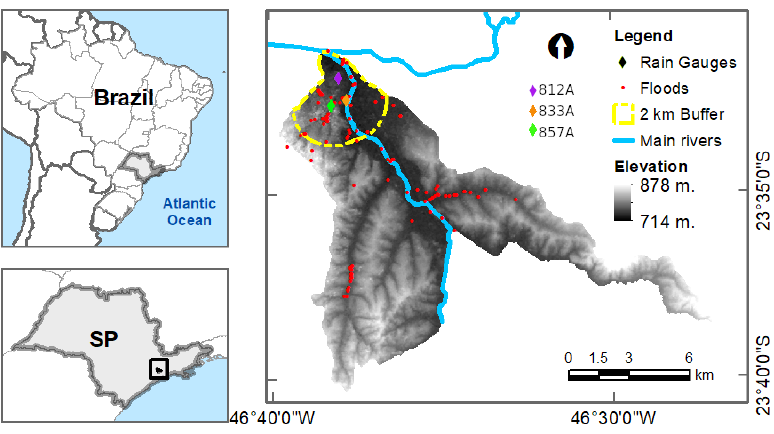
Figure 1. The lower part of the Tamanduateí Basin is depicted in the diagram, with diamonds indicating the locations of rain gauges, red markers indicating flood zones, and light blue representing the main hydrography. A 2-km buffer around the rain gauge locations is delineated by the yellow line, while the elevation of the study area is depicted by the black and white